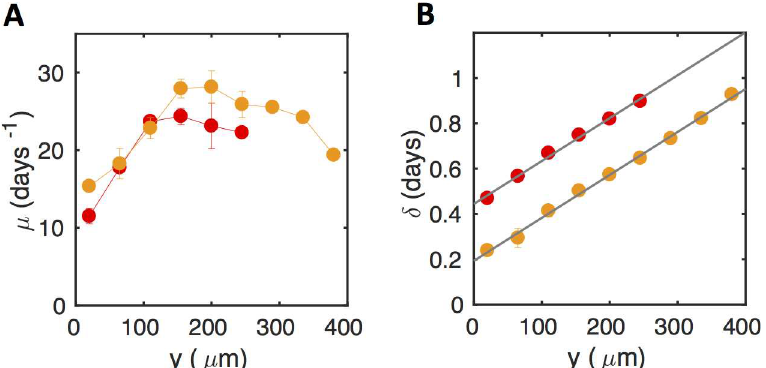
Fig 5. Local growth rate and lag time in the advancing-front growth mode characterize the biofilm spatial spreading. Biofilm growth rate, μ (A) as derived from the exponentialadjustment, (see Fig 3) and apparentlag time δ (B), as a function of the lateral locationin the channelsin the high bottom shear stress regime( > 10 mPa)—the 250 μ m-heightone (red dots) and the 350 μ m-heightone (orange dots). The slope of the lag time linear adjustment(grey line) provides the front propagationvelocity. Means and SDs over two positionsare represented.Plot of a representative experimentof at least three (see data statistical dispersion in S1